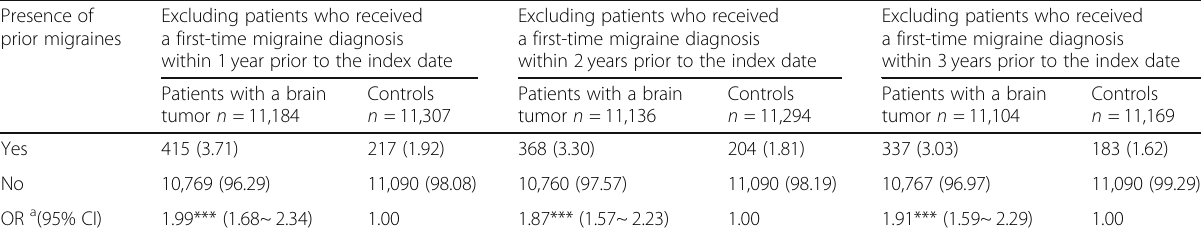
Table 3 Sensitivity analysis Presence of prior migraines